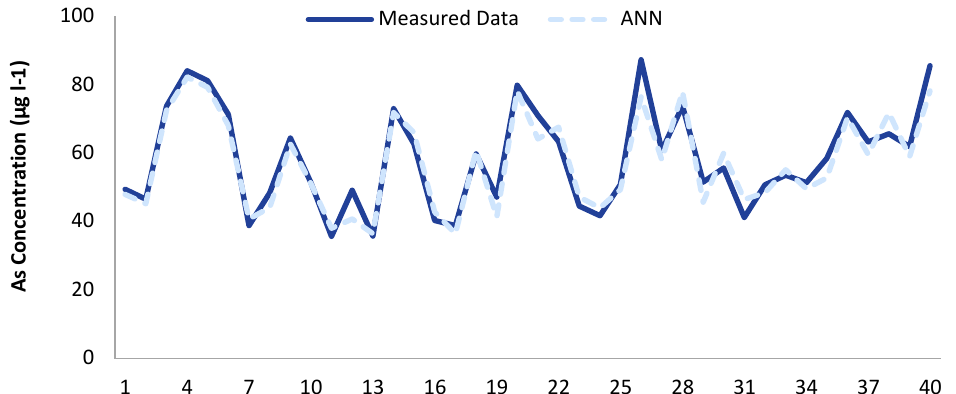
Figure 3. Comparison of the actual groundwater heavy metal concentration values and those predicted for As in testing phase ANN: Artificial neural